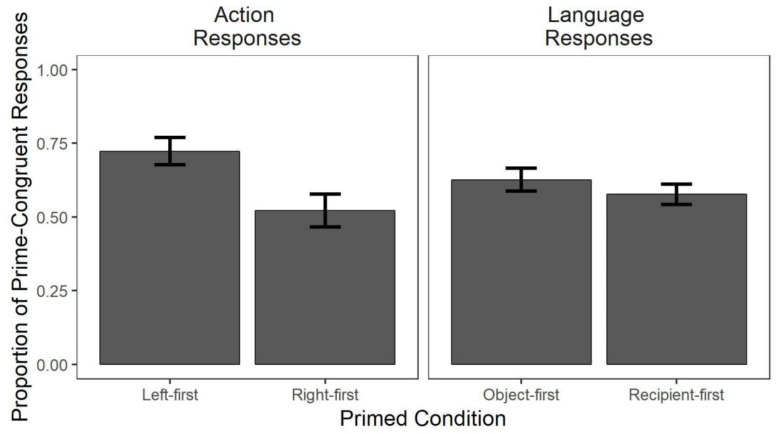
Proportion of target trials in which participants produced prime-congruent responses. For action targets, bars reflect the proportion of screen touches that match the primed direction from the Start diamond (left-first/right-first, totaling to 1). For language targets, bars reflect the proportion of utterances (object-first/recipient-first, totaling to 1) that matched the structure of the primed object/recipient ordering. Means and standard errors are calculated over each participant’s mean score. Overall, prime order predicts rates of prime-congruent vs. prime-incongruent responses in both action and language trials, and for action trials the size of priming is greater for left-first primes.